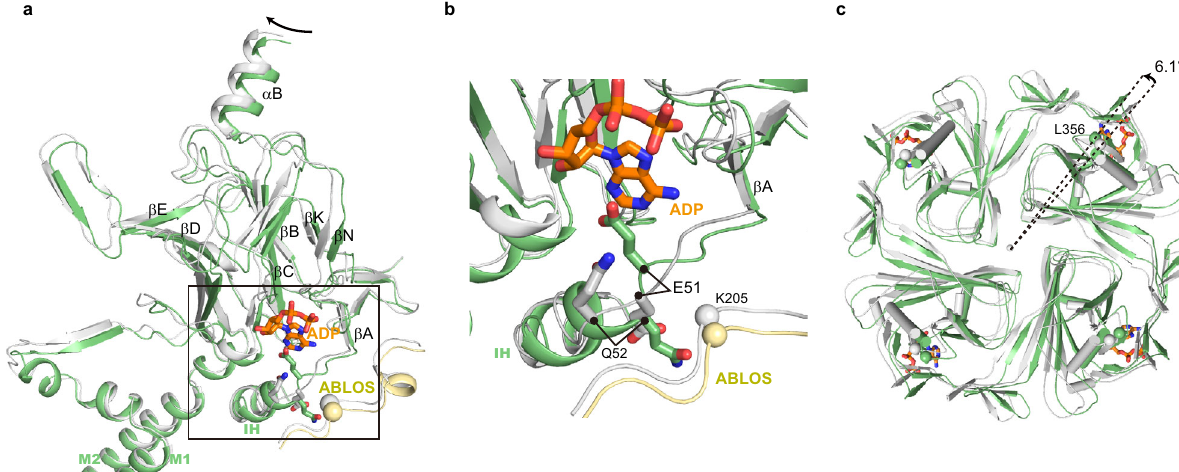
Fig. 3 Conformational changes of Kir6.2 CTD during K ATP channel opening. a Conformational changes of the nucleotide-binding site between the closed (gray) and the pre-open (green) states of H175K cryo-EM . The ADP bound in the closed state is shown as sticks in orange. b Close-up view of the nucleotide- binding site boxed in ( a ). c Bottom view of the Kir6.2 CTD. The rotation angle between CTDs was measured using C α positions of L356 of Kir6.2 as marker atoms (shown as